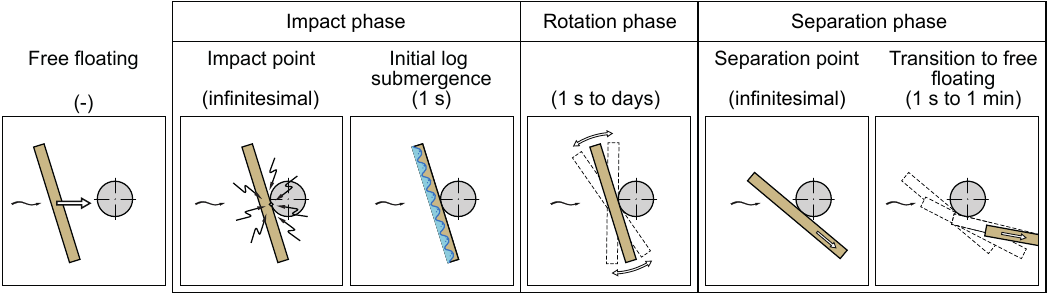
Figure 6. Schematic overview of the accumulation process of a single log at a bridge pier with the three phases impact , rotation , separation , and their subprocesses. The values in brackets indicate an approximate time-scale for the process duration based on video